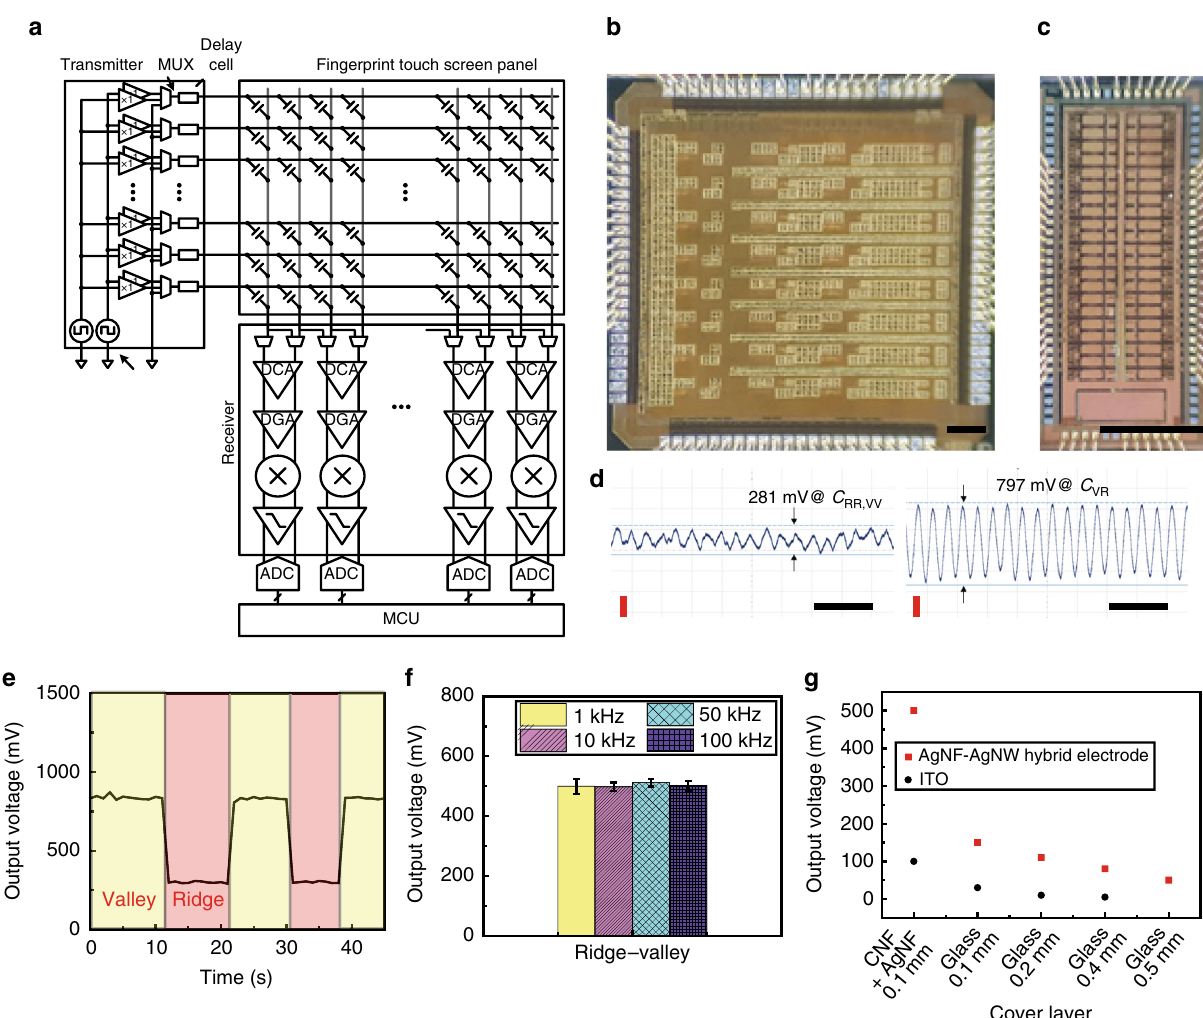
Fig. 4 Custom-designed fi ngerprint sensor readout circuit. a Block diagram of the fi ngerprint sensor readout circuit. b Fully differential receiver for fi ngerprint recognition. Scale bar is 250 μ m. c High-voltage transmitter. Scale bar is 1 mm. d Measurement result of the sensing ridge to the valley indicated the analog voltage outputs of the proposed IC and the fi ngerprint TSP (1 MHz, 1 V). Output voltages are 281 and 797 mV under ridges and valleys. Y -axis scale bar (red) is 200 mV and the x -axis scale bar (black) is 2 μ s. e Waveform output voltage change during the fi ngerprint sweep. f Output voltages of the